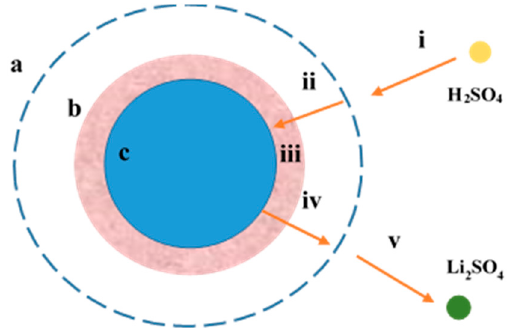
Figure 11. Diagram of the reaction process between lepidolite concentrate powder and sulfuric acid ( a ), the product layer; ( b ), the reaction interface; and ( c ), the unreacted core of the lepidolite particles).